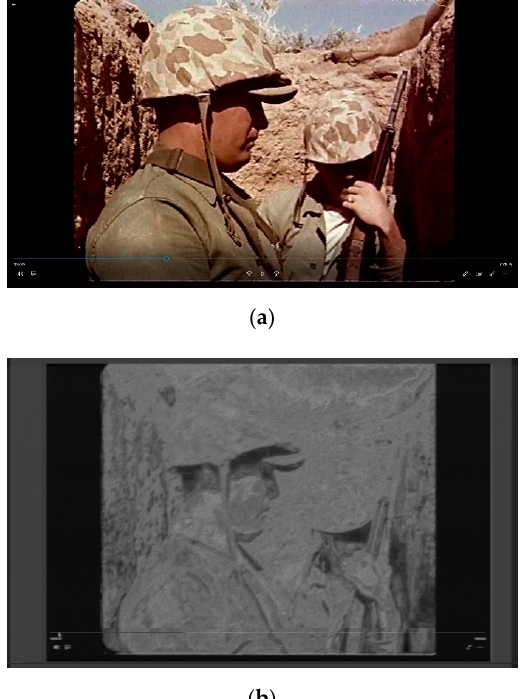
Figure 16. Example images. ( a ) A frame from a movie displayed on a computer (Prelinger Archives, resolution 1920 × 1080), and ( b ) the restored image of the frame displayed on a computer monitor ( f o = 1155 MHz, BW = 50 MHz, sampling frequency f s = 125 MHz) using DVI